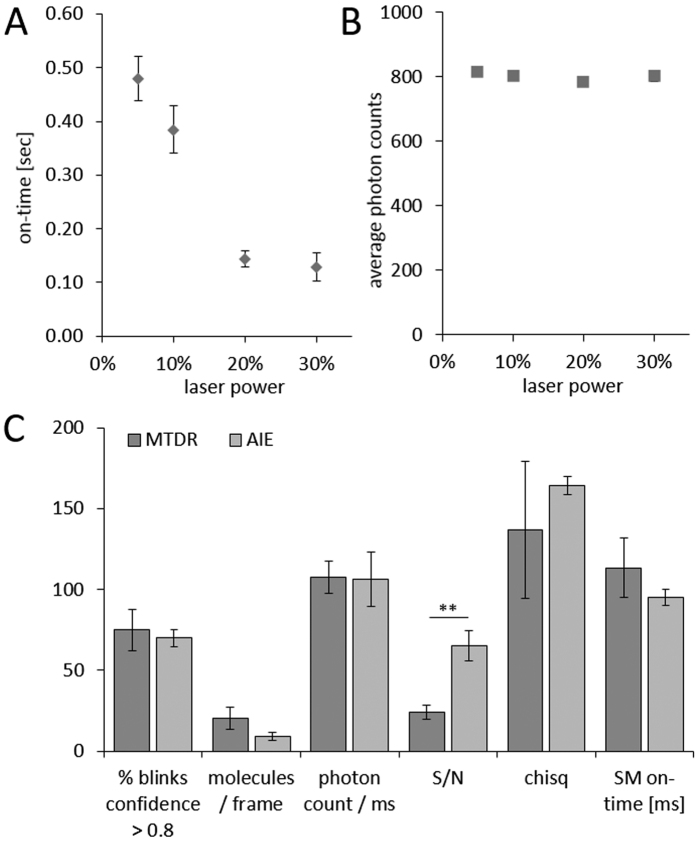
MitoRed AIE Single Molecule Statistics.(A) Average on-time of single MitoRed AIE dye molecules decreases significantly with increased excitation laser power while (B) average photon counts remain unaffected. (C) Single molecule blinking statistics of MitoRed AIE dye are similar or superior to MitoTracker Deep Red (MTDR). Signal-to-noise ratio (S/N) of single molecule blinks was 2.7 fold higher for our MitoRed AIE probe than for MTDR (p = 0.009, n = 8). **Indicates statistical significance with p < 0.01. As the y axis labeling differs for each of the experiments listed along x, the y axis labeling is included in the x axis description.